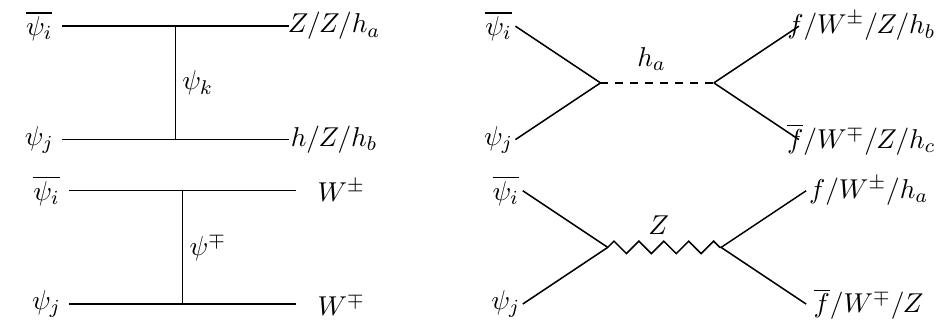
Figure 15 . Annihilation ( i = j ) and Co-annihilation ( i 6 = j ) type number changing processes for Vector like fermionic DM in the model. Here i; j; k = 1 ; 2; a; b; c = 1 ; 2 ; 3 and f stands for SM fermions.